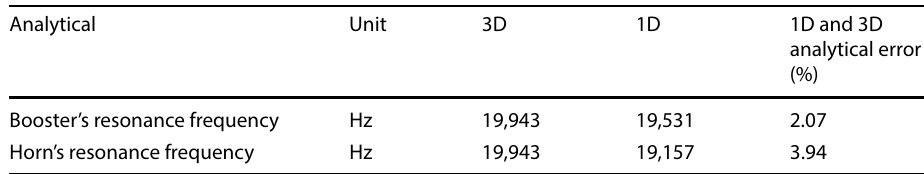
Table 7 1D and 3D analytical